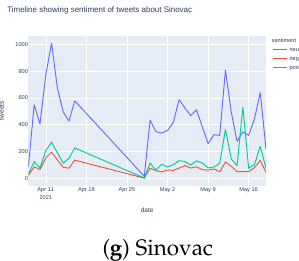
Figure 6. Public sentiment for different vaccines with timeline using TextBlob.